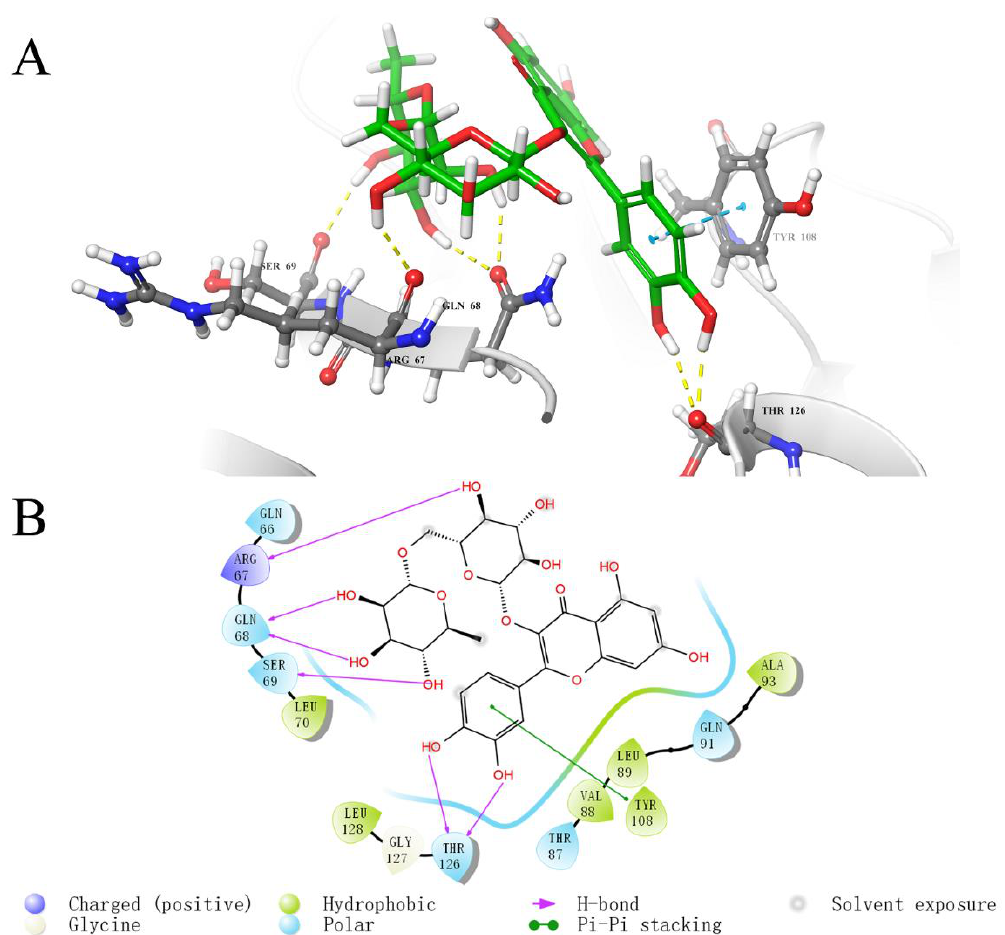
Figure 8. Molecular docking diagram of the interaction between rutin and LolB. ( A ): Detailed view of the LolB–rutin interaction sites. Amino acid residues involved in binding are shown in stick representation. H bonds are shown as yellow dashed lines and pi–pi stacking interactions are shown as cyan dashed lines. Rutin is labeled in green. ( B ): 2D diagram of interaction.